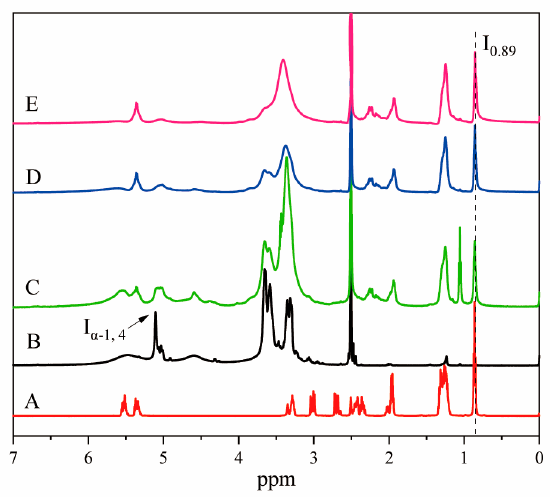
Figure 1. The hydrogen nuclear magnetic resonance ( 1 H-NMR) spectra of OSA (A), short glucan chains (SGC; B), OSA 0.25 –SGC (C), OSA 0.5 –SGC (D) and OSA 1.0 –SGC (E). Table 1. Effect of the ratio of OSA/SGC on degree of substitution (DS) and RE (reaction efficiency). Sample